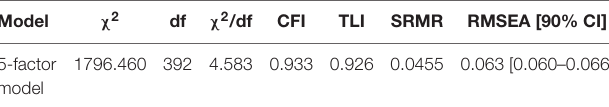
TABLE 7 | Indicator fit of the five-factor structural model of the Chinese Revision of the Pitt Wellness Scale ( n =